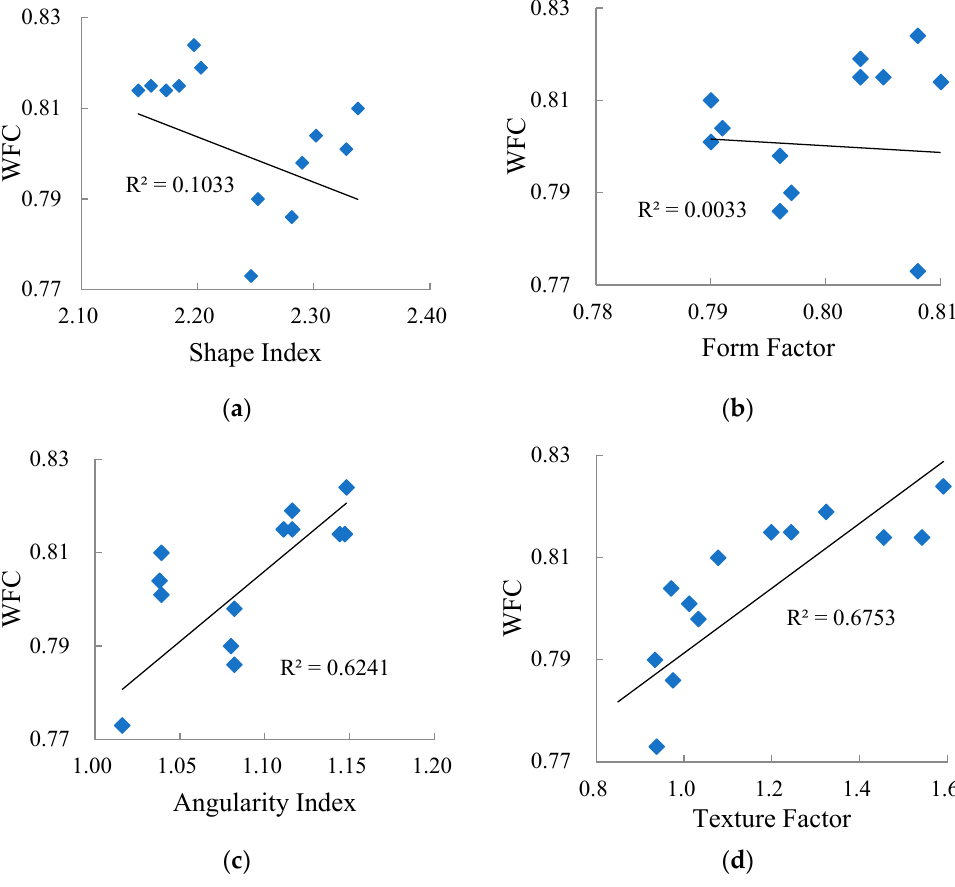
Figure 11. Correlation between WFC and four aggregate geometric characteristic parameters: ( a ) Average shape index, ( b ) Average form factor, ( c ) Average angularity index, ( d ) Average texture factor.